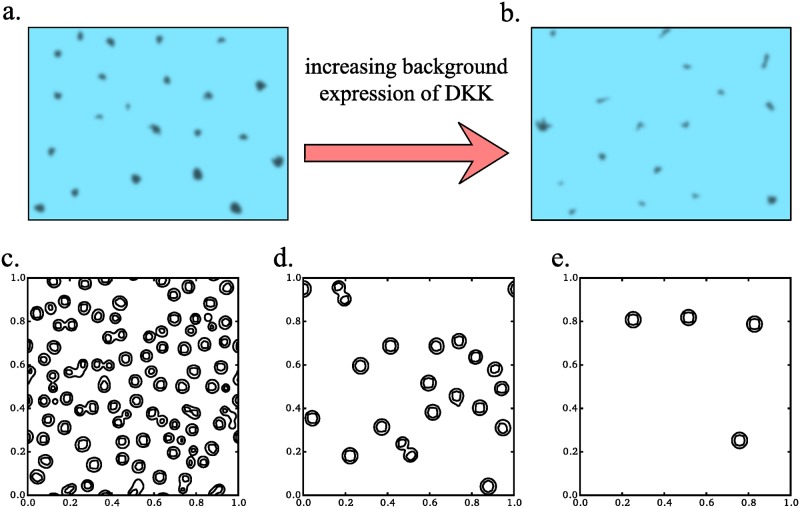
Simulation of follicle formation by using the extended GM model.WNT activation pattern in wild type (a) and DKK+ transgenic mice (b) redrawn from [30]. Turing structures formed from homogenious noise in 5 minutes (internal time) with different levels of base DKK expression: 0.1, 0.15 and 0.2 μM/s (c-d). Other parameters used are shown in Table 1.